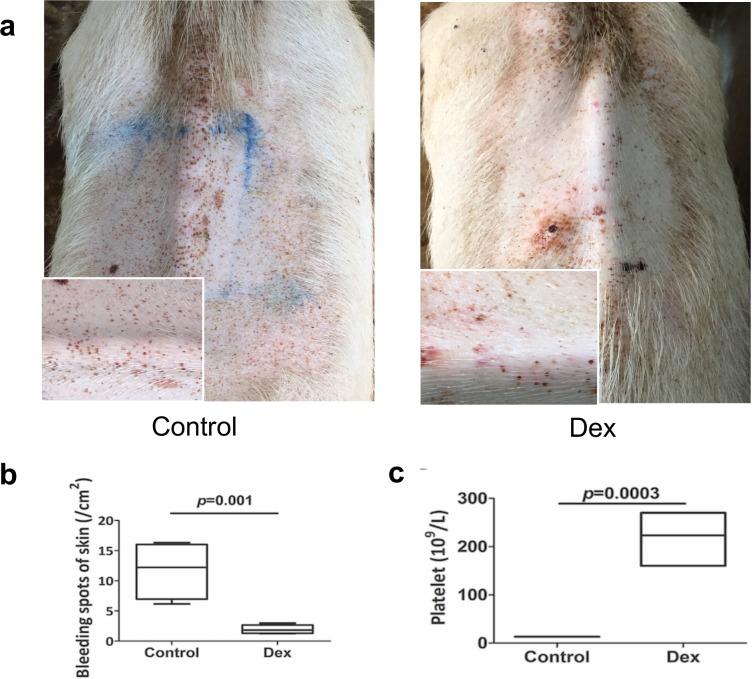
Inhibitory immune therapy rescues the subcutaneous bleeding phenotype.(a) An image of leptin-overexpressing pigs with or without Dex treatment. (b) Statistical analysis of the bleeding spots (control n = 1, Dex n = 3). (c) Platelet content in both groups of pigs (control n = 1, Dex n = 3). p < 0.05 shows significance difference, two-tailed Student t test for b,c. Data are presented as mean ± SEM. Numerical values are provided in S1 Data. Dex, dexamethasone.